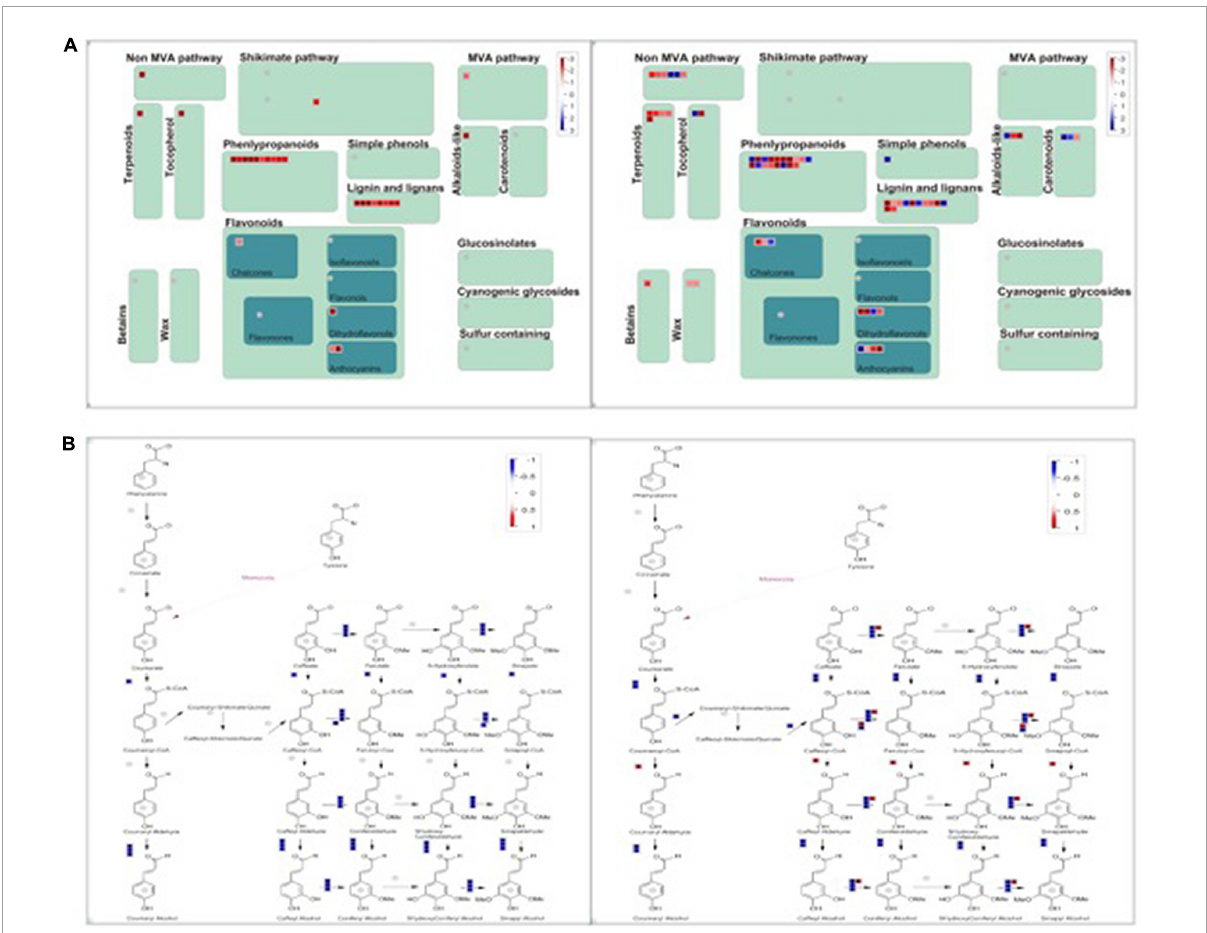
FIGURE6 MapMan-based visualization of the transcripts involved in "secondary metabolism" in experimental groups (a). (A) The secondary metabolism pathway compares groups S (left) and D (right) at 12hpi. Functional subBINs shown in red or blue indicate up/down-regulation, respectively. (B) All DEGs involved in the pathway of phenylpropanoids in both groups S (left) and D (right) at 12 hpi. (B) The DEGs are involved in the Phenylpropanoids synthesis Pathway.